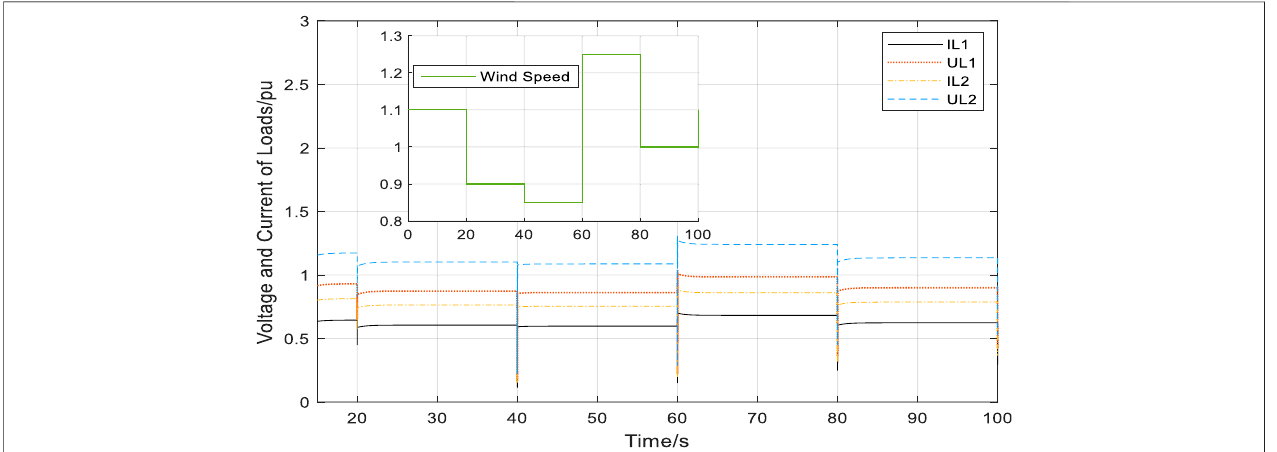
FIGURE 10 | Voltage and current curves on load with wind speed change of the improved APME model.